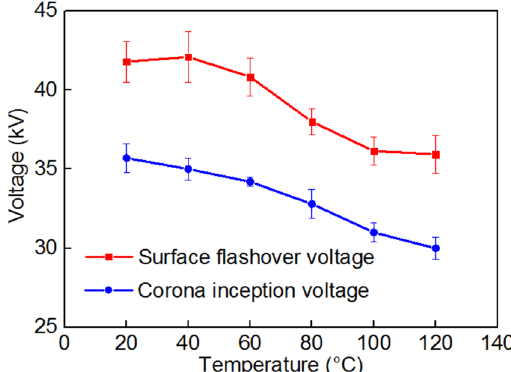
Figure 5. Surface flashover voltage and corona inception voltage at different